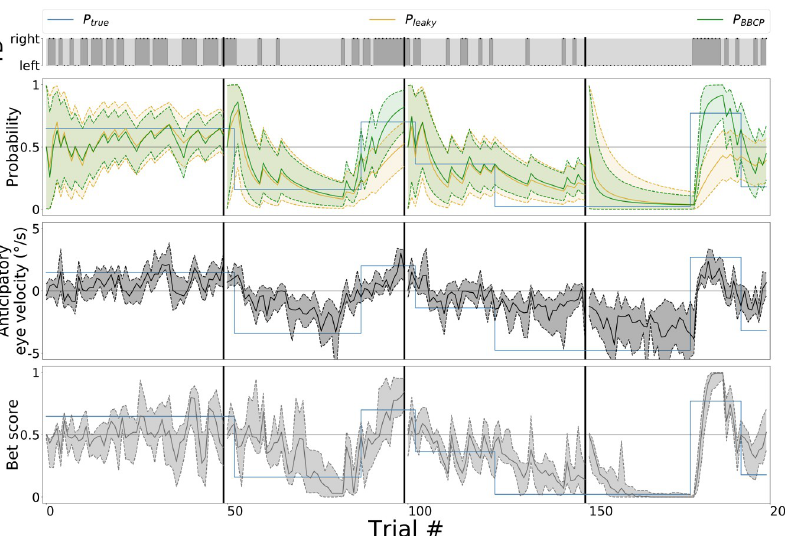
Fig 3. Behavioral results, qualitative overview. For one trial block of 200 trials, we compare the different model- estimated probabilities with respect to the behavioral results. The top row represents the sequence of target directions (TD) that were presented to observers and agents, as generated by the binary switching model (see Fig 1A). We show the evolution of the value of the (true) probability bias P true (blue line) which is hidden to observers and that is used to generate the TD sequence above. We have overlaid the results of the probability bias predicted with a leaky integrator ( P leaky , orange line) and with the BBCP model ( P BBCP , see Fig 2B, green line). Bottom two rows display the raw behavioral results for the n = 12 observers, by showing their median (lines) and the .25 and .75 quantiles (shaded areas): First, we show the anticipatory pursuit eye velocity, as estimated right before the onset of the visually-driven pursuit. Below, we show the explicit ratings about the expected target direction (or bet scores ). These plots show a good qualitative match between the experimental evidence and the BBCP model, in particular after the switches. Note that short pauses occurred every 50 trials (as denoted by vertical black lines, see main text), and we added the assumption in the model that there was a switch at each pause. This is reflected by the reset of the green curve close to the 0.5 level and the increase of the uncertainty after each